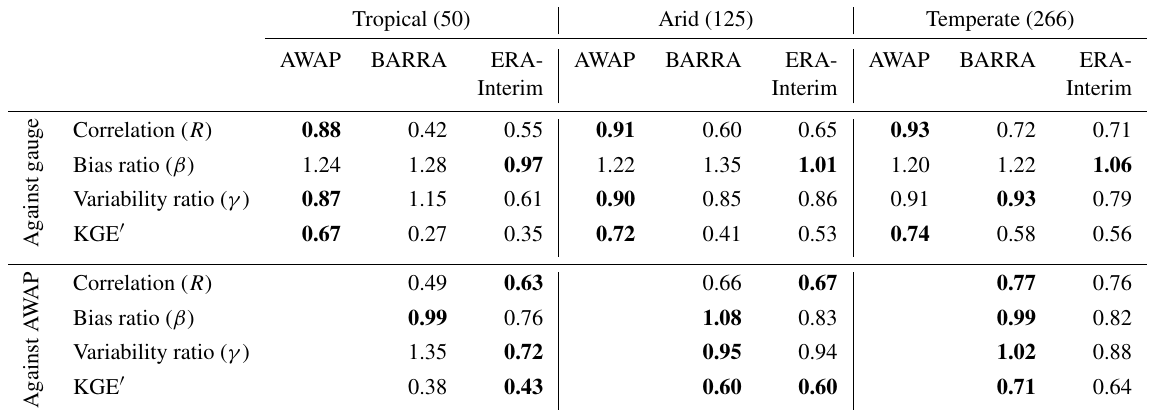
Table 2. Median values of KGE (cid:48) and its components grouped for broad Köppen–Geiger climate categories for Australia. The number in brackets indicates the number of stations in the climatic zones. Values in bold represent the best score in each group. Tropical (50) Arid (125) Temperate (266) AWAP BARRA ERA- AWAP BARRA ERA- AWAP BARRA ERA- Interim Interim